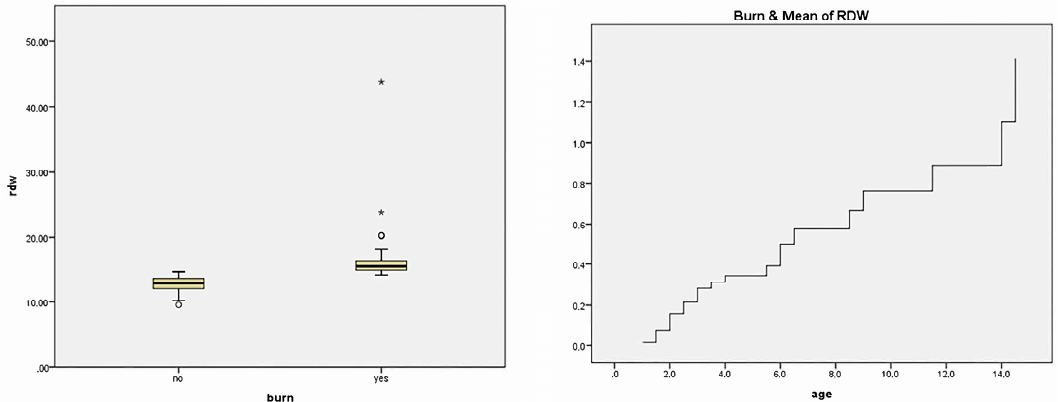
Figure 1. Distribution of red cell distribution width (RDW) between groups and proportional hazards (COX) regression hazard analysis 。